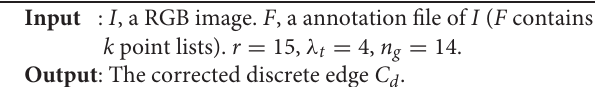
Algorithm 1: LLPC Label Correction